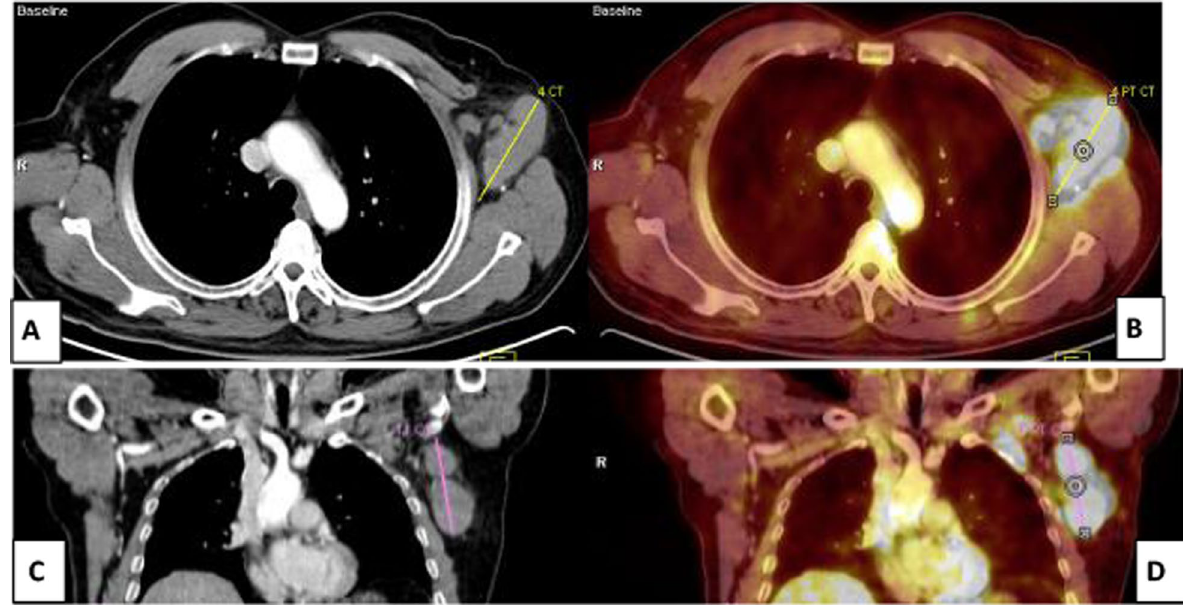
Fig. 5 A 45-year-old male patient with NHL, treated with anti-cd20 antibody rituximab 25 months prior to vaccination. The most recent PET/CT showed enlarged amalgamated left axillary LNs. Further clinical data revealed that he got his 2nd dose of Pfizer-BioNTech vaccine 9 days before the PET-CT study. So, these findings were ascribed to recent vaccination. A Axial and C coronal CECT images revealed enlarged amalgamated left axillary LNs about 8 cm. B Axial and D coronal PET/CT images revealed FDG-avid left axillary LNs of 17